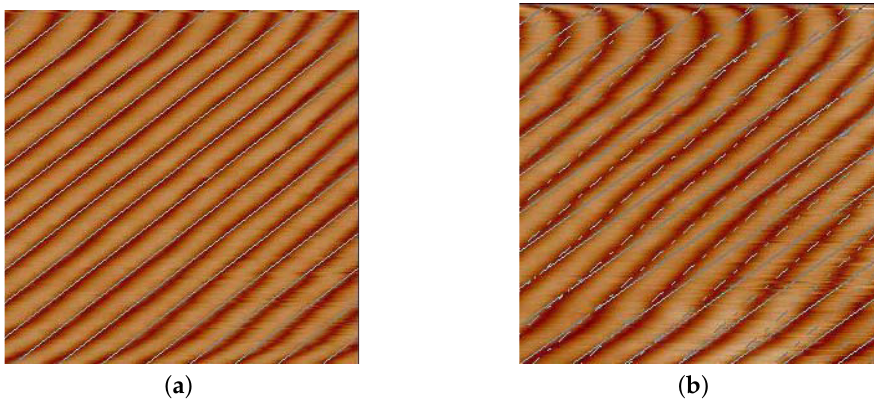
Figure 2. Measuring images with hysteresis and creep compensation vs. no compensation at a 0.5 Hz scanning rate. ( a ) With hysteresis and creep compensation. ( b ) Without hysteresis and creep compensation. Note: these two images are measured with a CSPM5500